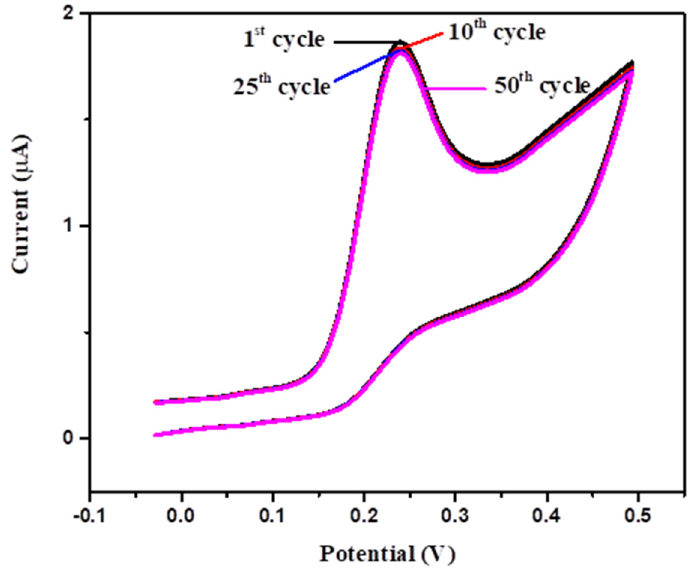
Figure 7. CVs of MGCE (1st, 10th, 25th, and 50th cycle) in 80 µM serotonin in 0.1 M PBS (pH = 7.0) at scan rate of 50 mV/s.